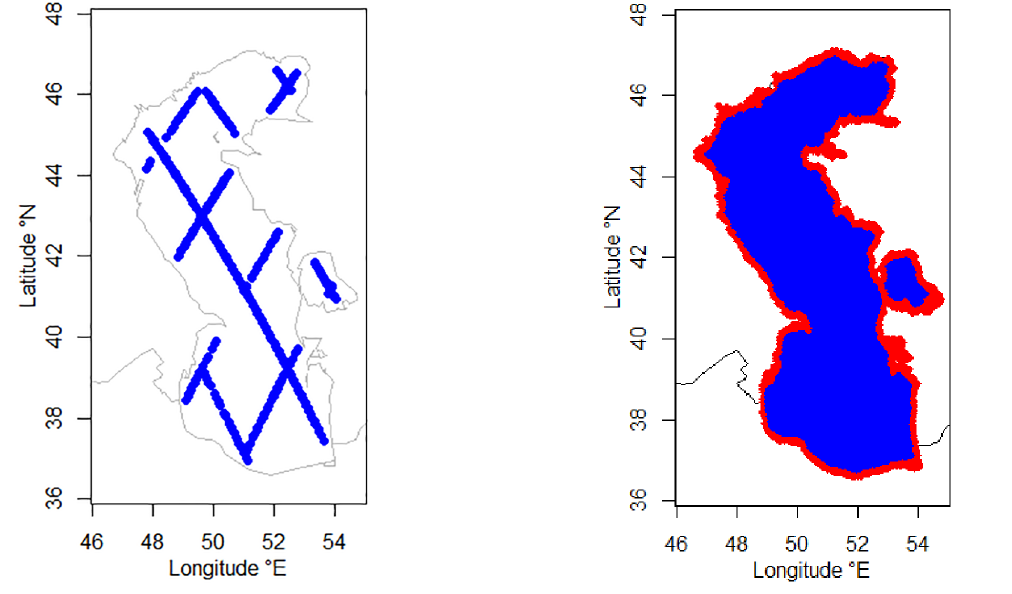
Fig. 3. JASON-1 tracks (blue lines) over the Caspian Sea during one month of observations (April 2008, left) and the whole period of 2002–2013 (right). The altimeter tracks are shown in blue. Red points show the measurements located within <0.2  from the coast which were excluded from the